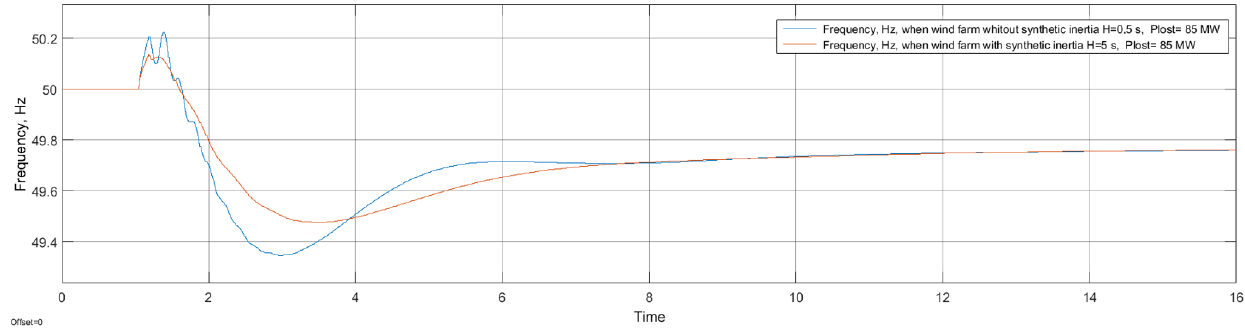
Figure 11. Frequency nadir in power system during 3ph short circuit following 85 MW disconnection.